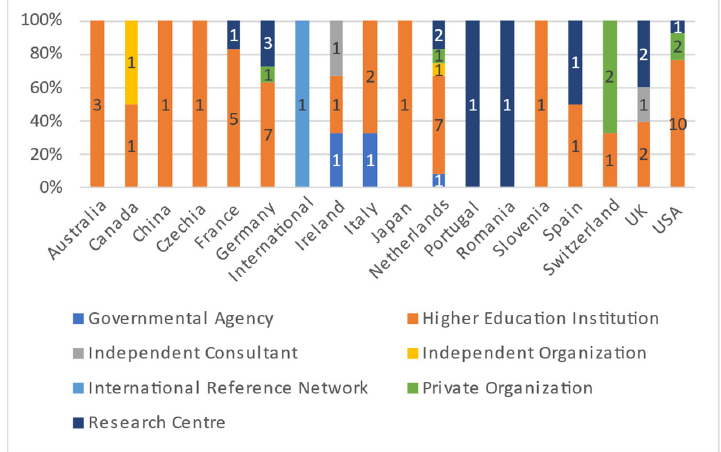
Figure 5. Distribution of Entity Types per territorial-administrative areas.